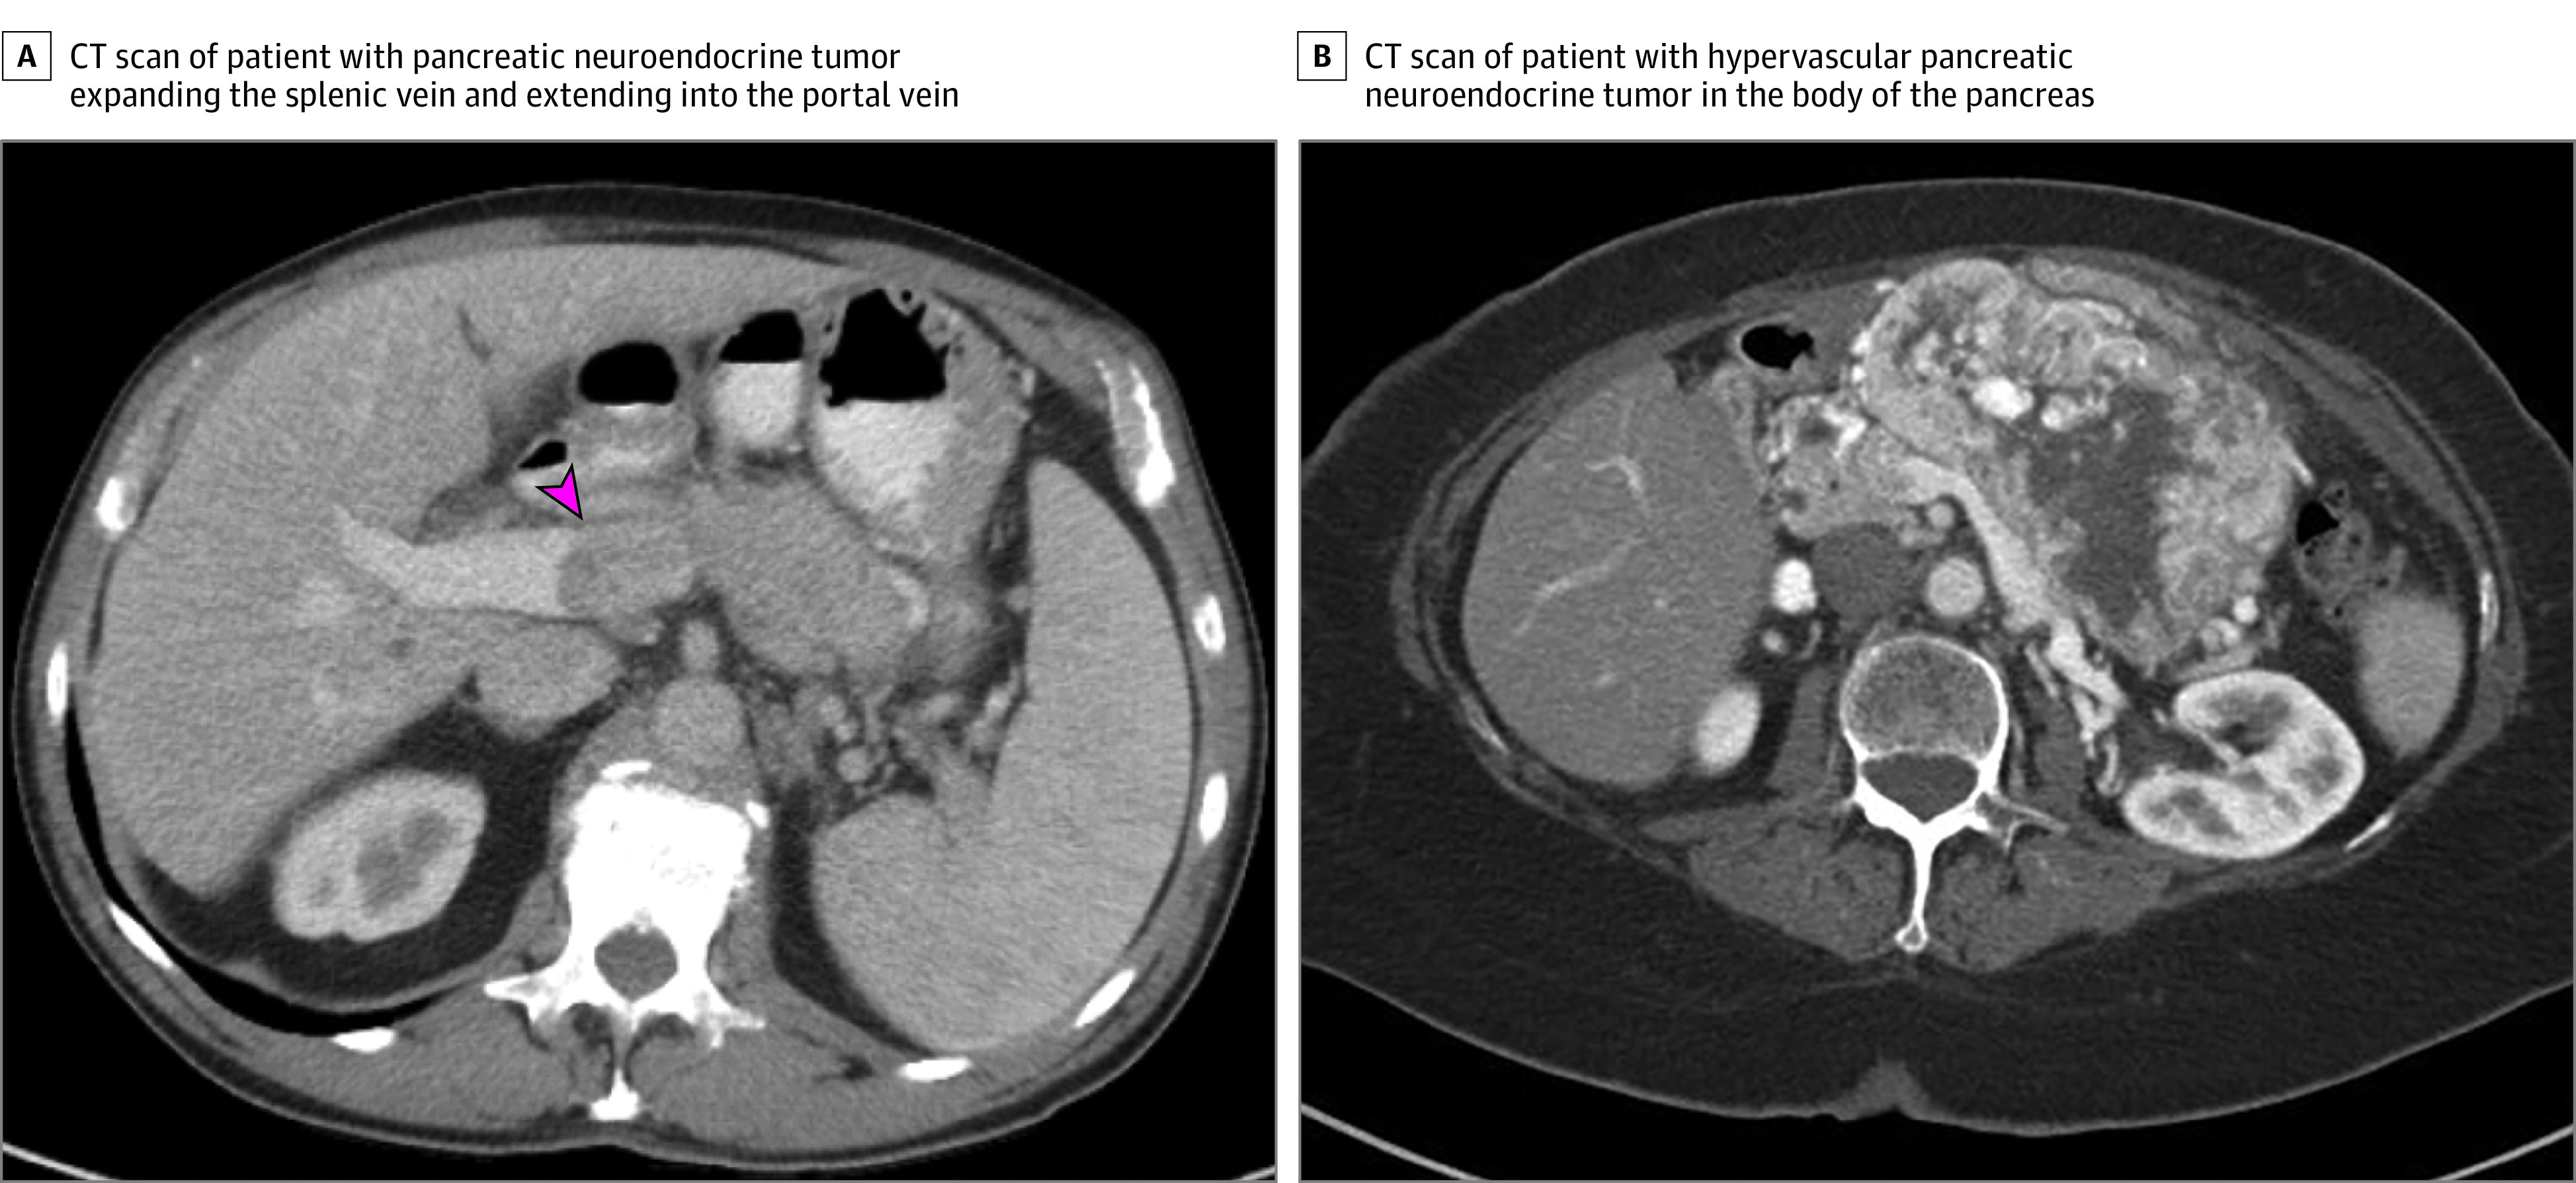
Two Examples of Patients With Locally Advanced Pancreatic Neuroendocrine Tumor Included in This StudyA, A computed tomographic (CT) scan showing a patient with an 8 × 2 cm pancreatic neuroendocrine tumor expanding the splenic vein and extending into the portal vein (arrow); B, A CT scan showing another patient with an 8 × 12 cm hypervascular pancreatic neuroendocrine tumor in the body of the pancreas causing mass effect on the splenic vein and porto-splenic confluence.